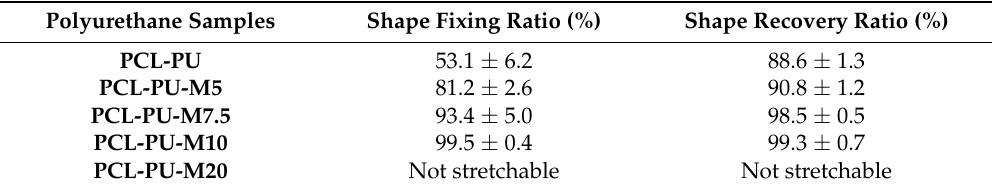
Table 2. Shape fixing and shape recovery ratios of the PCL-PU and PCL-PU-Chitosan polyurethane biocomposites.